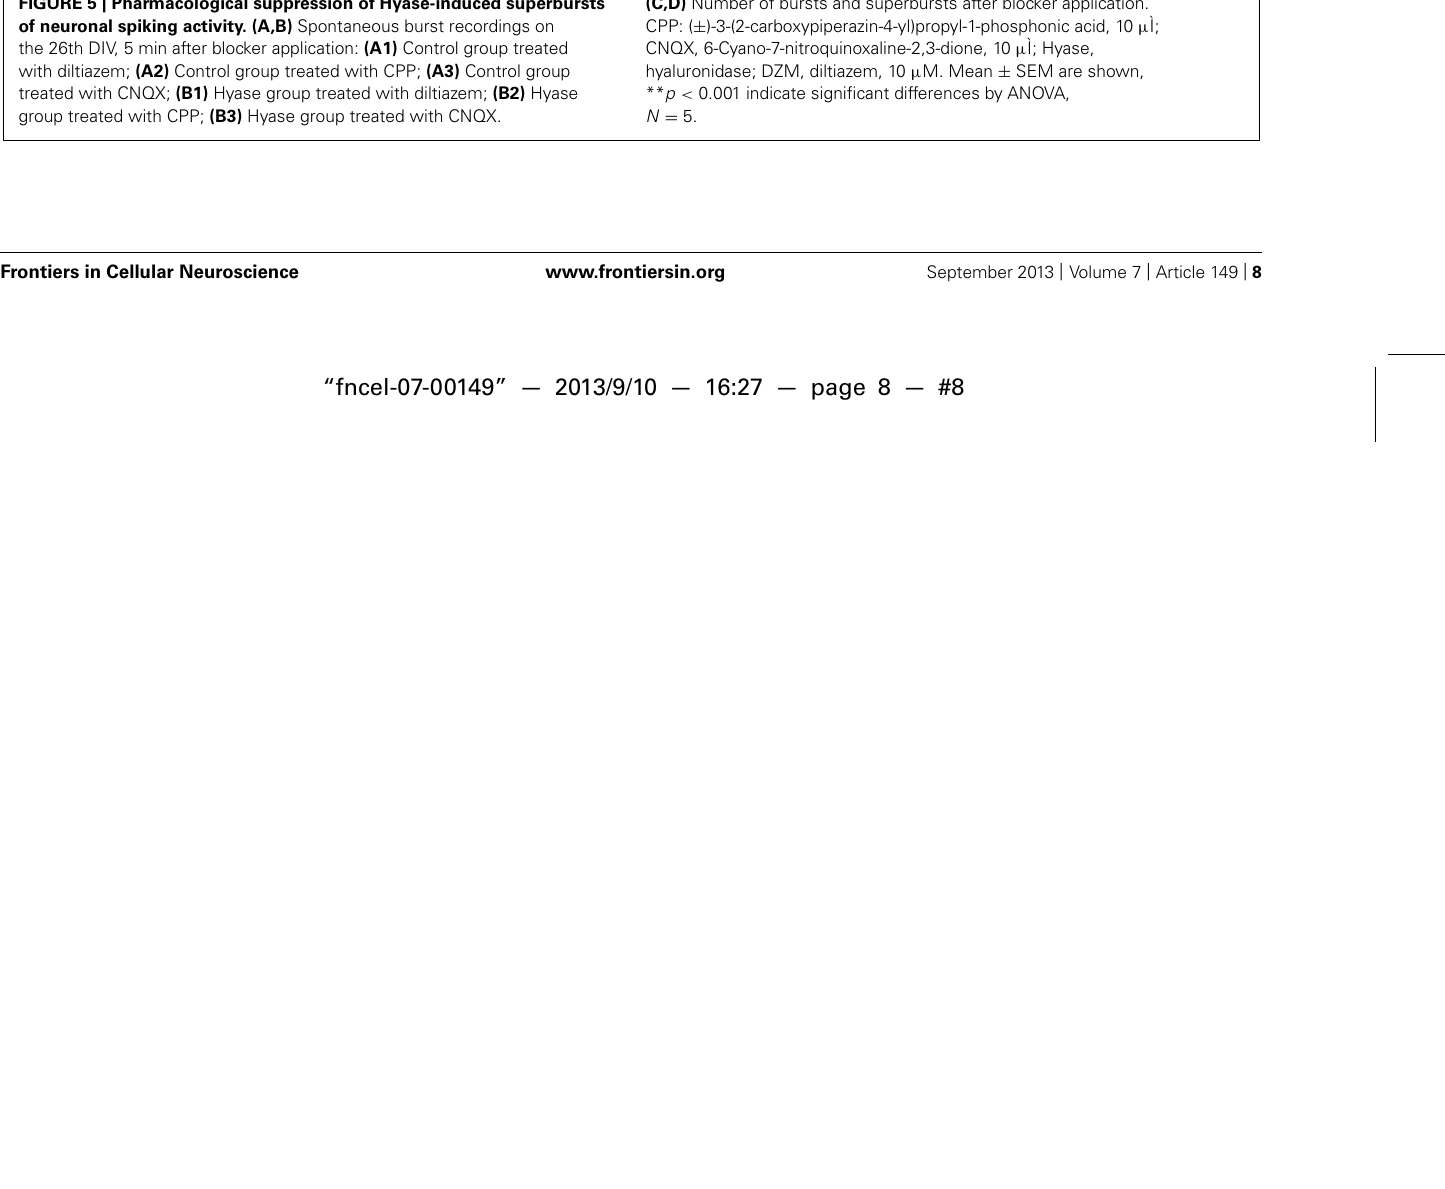
FIGURE 5 | Pharmacological suppression of Hyase-induced superbursts of neuronal spiking activity. (A,B) Spontaneous burst recordings on the 26th DIV, 5 min after blocker application: (A1) Control group treated with diltiazem; (A2) Control group treated with CPP; (A3) Control group treated with CNQX; (B1) Hyase group treated with diltiazem; (B2) Hyase group treated with CPP; (B3) Hyase group treated with CNQX.